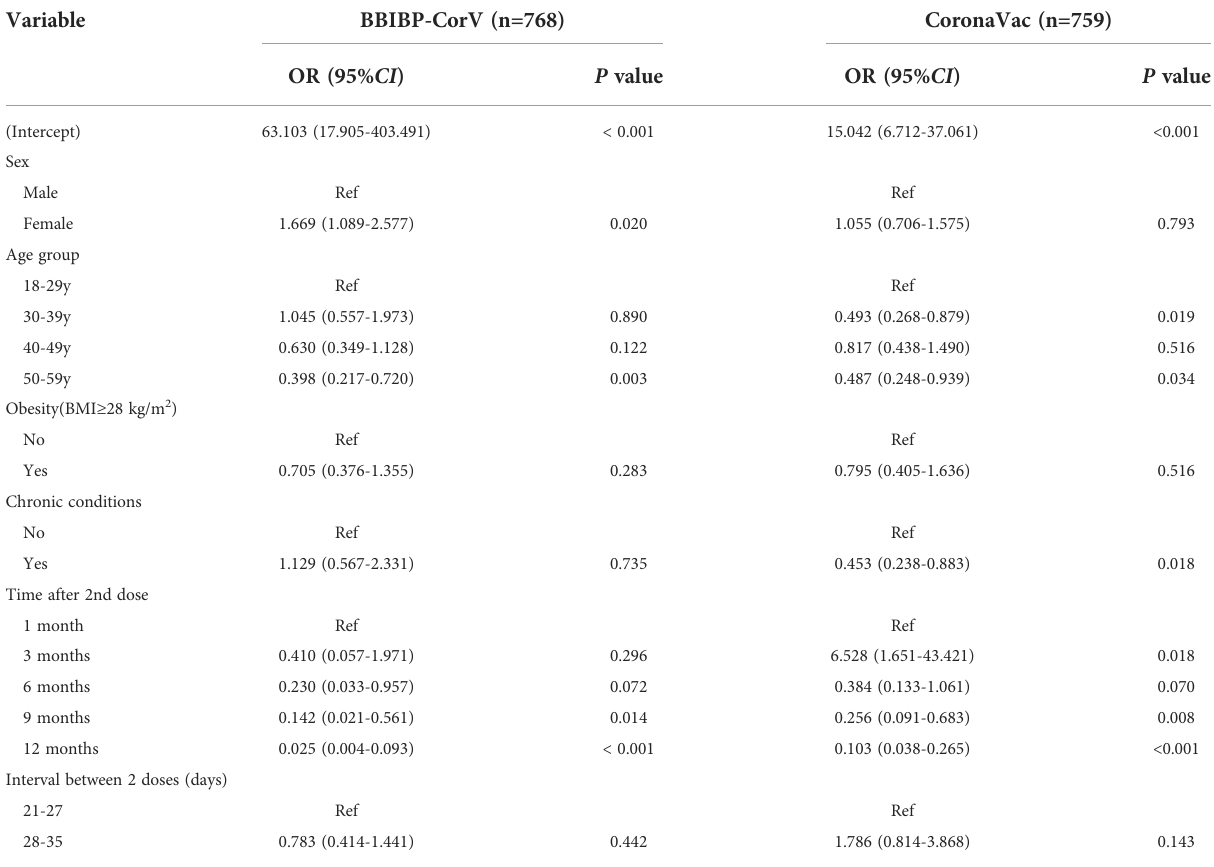
TABLE 3 Logistic regression analyses of NT 50 positivity rates of